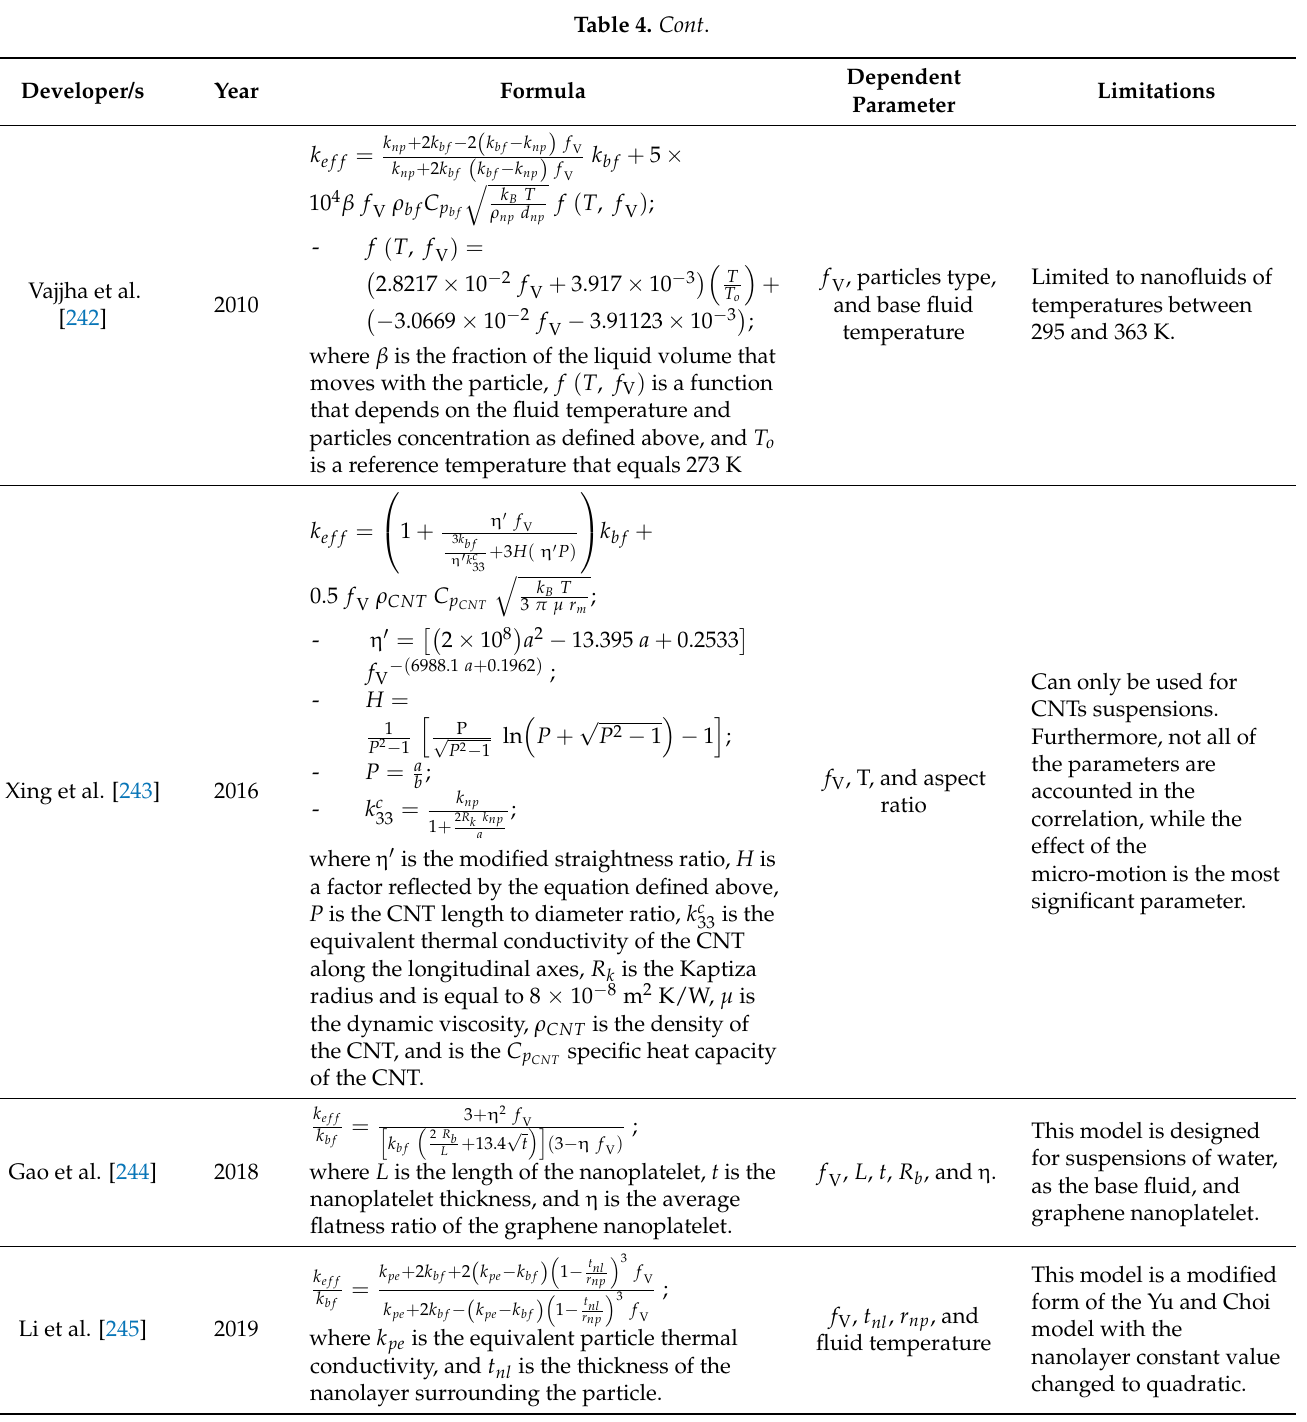
Developer/s Formula